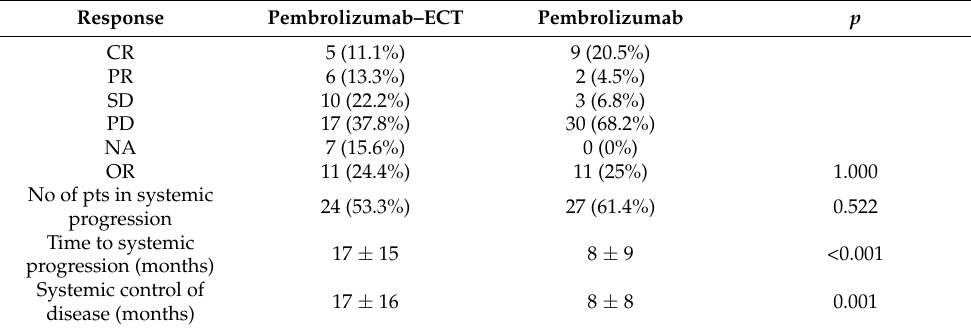
Table 4. Systemic response (immune-related